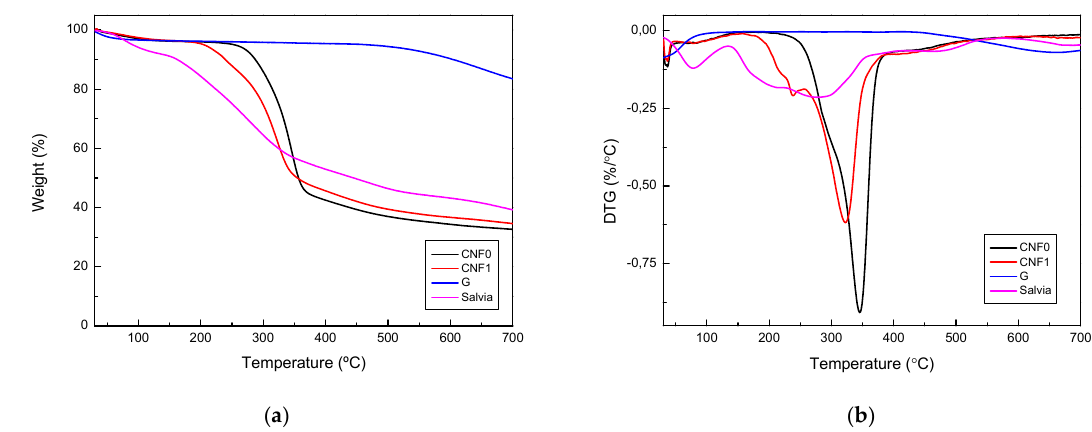
Figure 3. ( a ) TGA and ( b ) DTG curves of CNF0, CNF1, graphene and salvia extract.